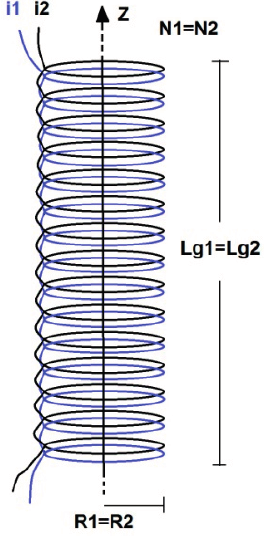
Figure 2. Concentric solenoids.